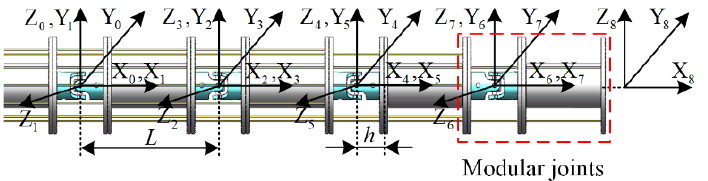
Figure 3. D-H coordinate system.